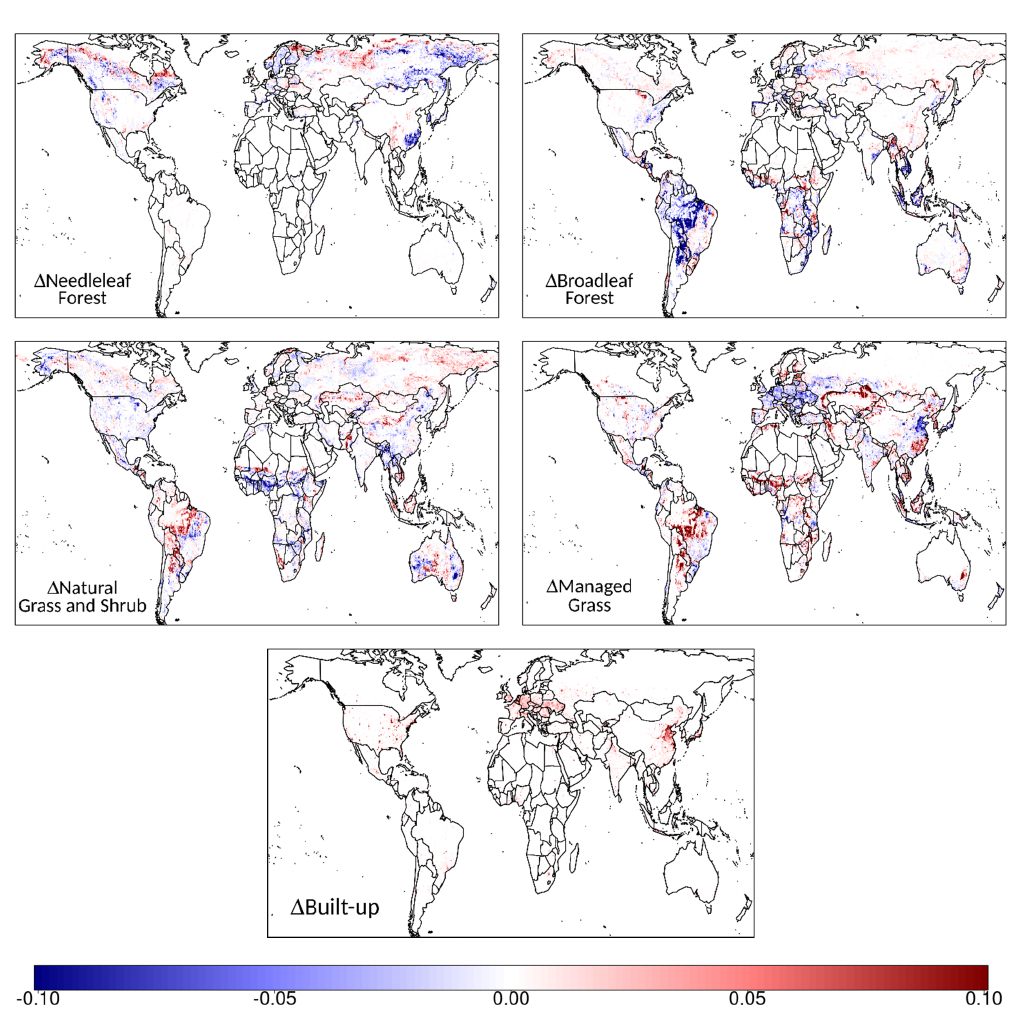
Figure 1. Global spatial patterns of 2014–1992 LULCC characterized by the changes in fractional coverage within a grid box (unitless) of major land cover types derived from the ESA CCI land cover product. Table 2. Global LULCC summarized by the changes in coverage of different land types (2014–1992) from the ESACCI land cover